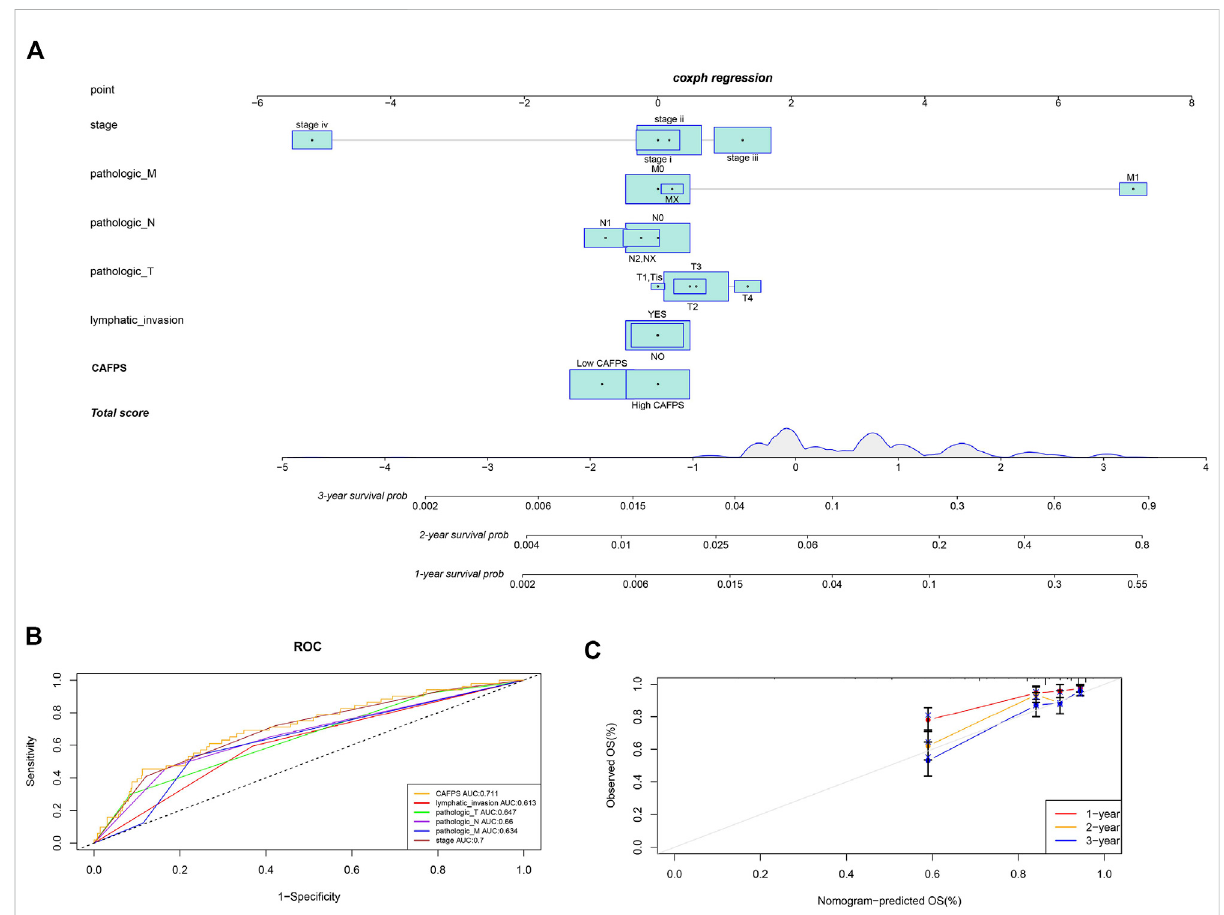
FIGURE 9 A nomogram was constructed to predict the survival of CRC patients in the TCGA cohort. (A) The nomogram for predicting the overall survival ofCRCpatientsat1,2,and3years. (B) TheROCcurvesofthenomogram,clinicalstage,TNMstage,andlymphaticinvasionforthesurvivalprediction of CRC patients at 1, 2, and 3 years. (C) The nomogram calibration curves of 1-, 2-, and 3-year survival